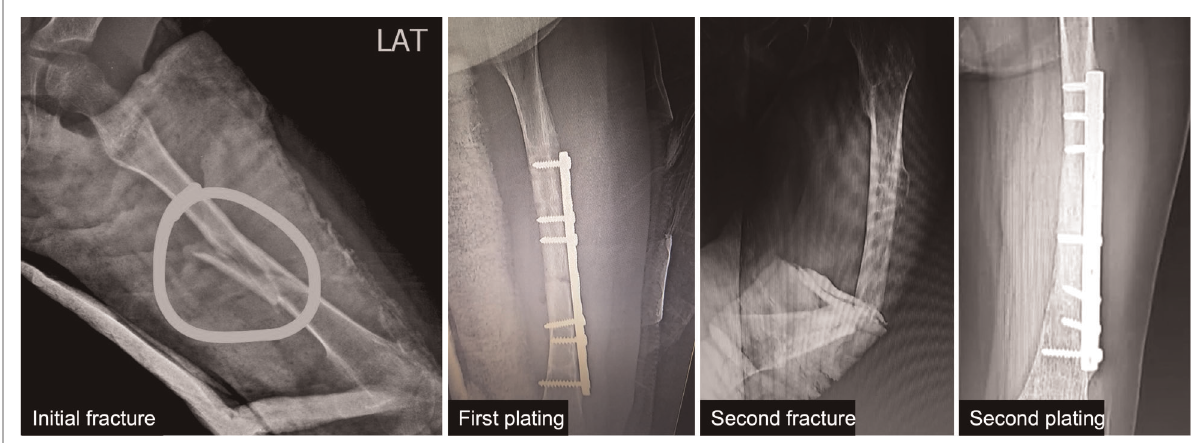
FIGURE 1 Patient ’ s x-rays. First x-ray shows the initial left femoral shaft fracture. Second x-ray shows the fi rst plating fi xation. Third x-ray shows the fracture after a slight twist of the leg. Fourth x-ray shows the second plating fi